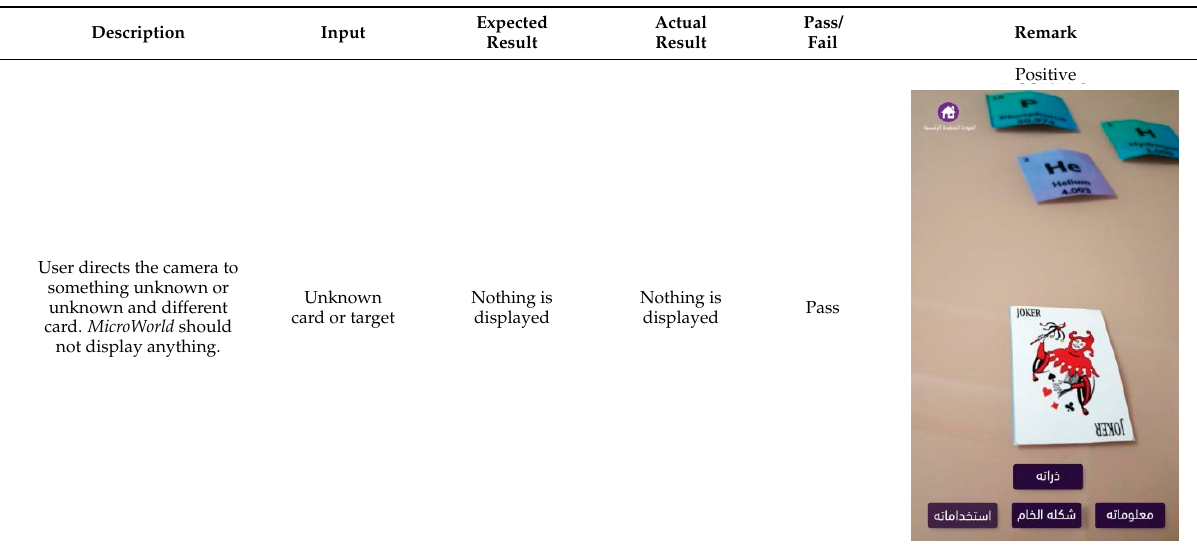
Table A3. Unit testing case of unknown card.